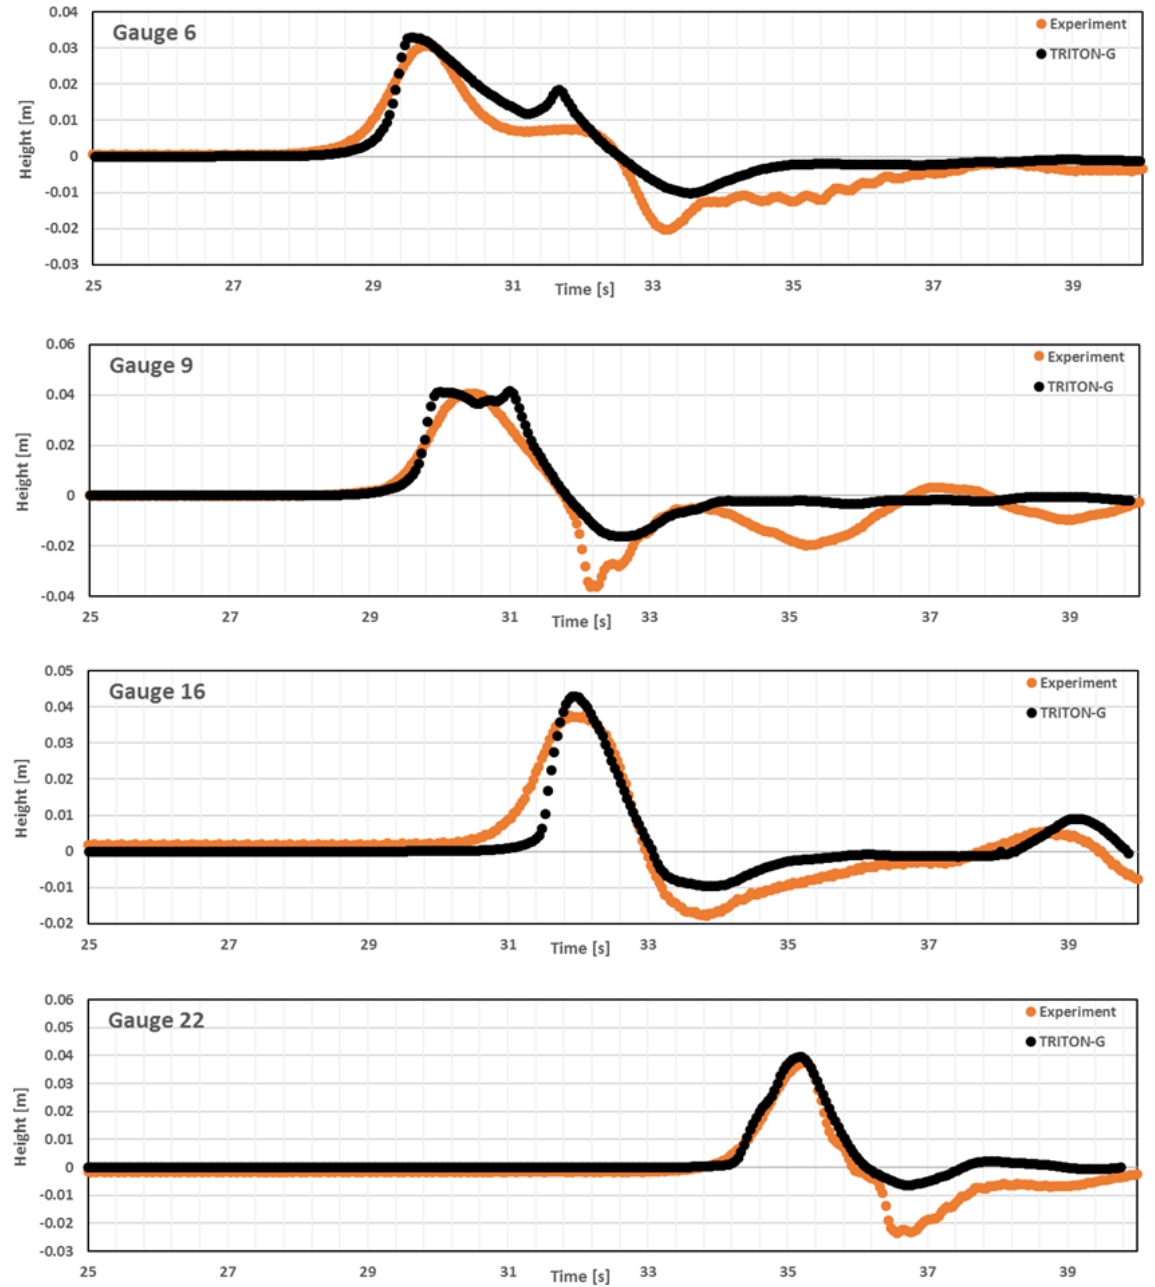
Figure A8. Comparison between computed and measured water levels at gauges 6, 9, 16 and 22 for case B ( H = 0 .